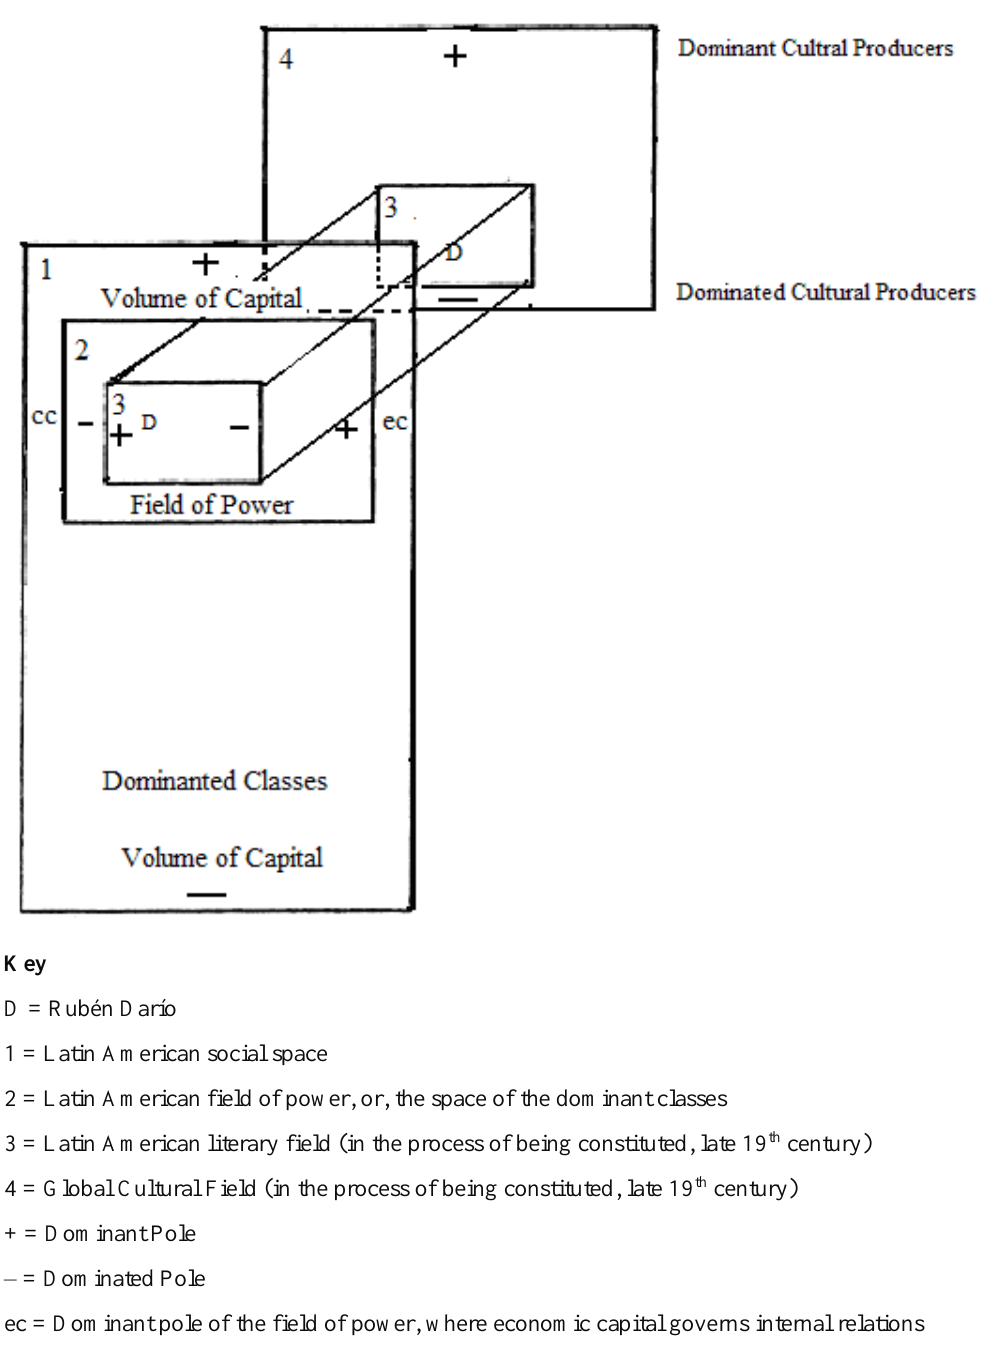
FIGURE 1. Darío in 19 th Latin American Social Space and Global Cultural